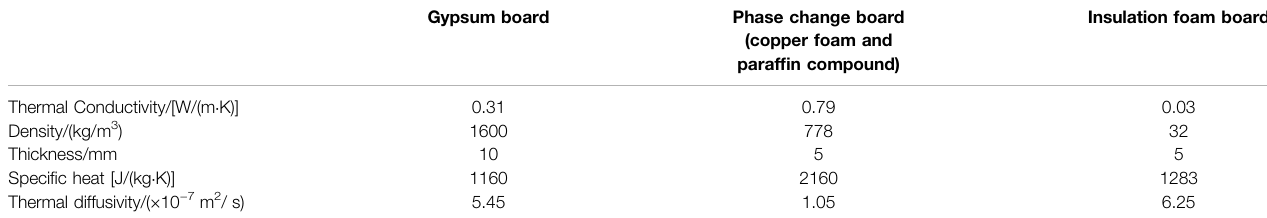
TABLE 1 | Thermophysical properties of